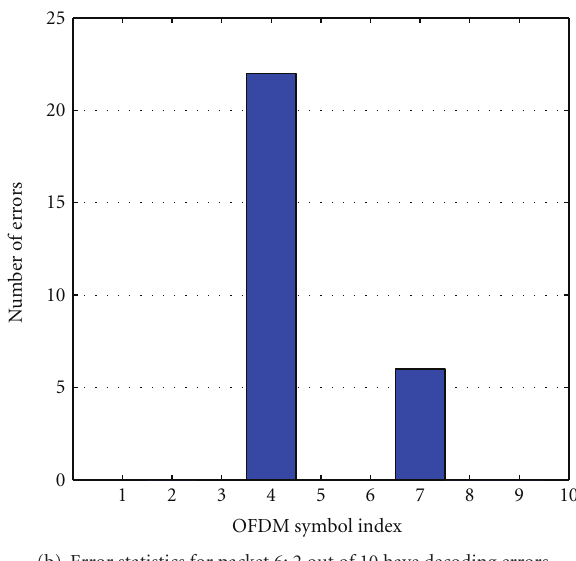
(a) BER for each packet over 1000m range, where the label 10 − 5 represents zero error